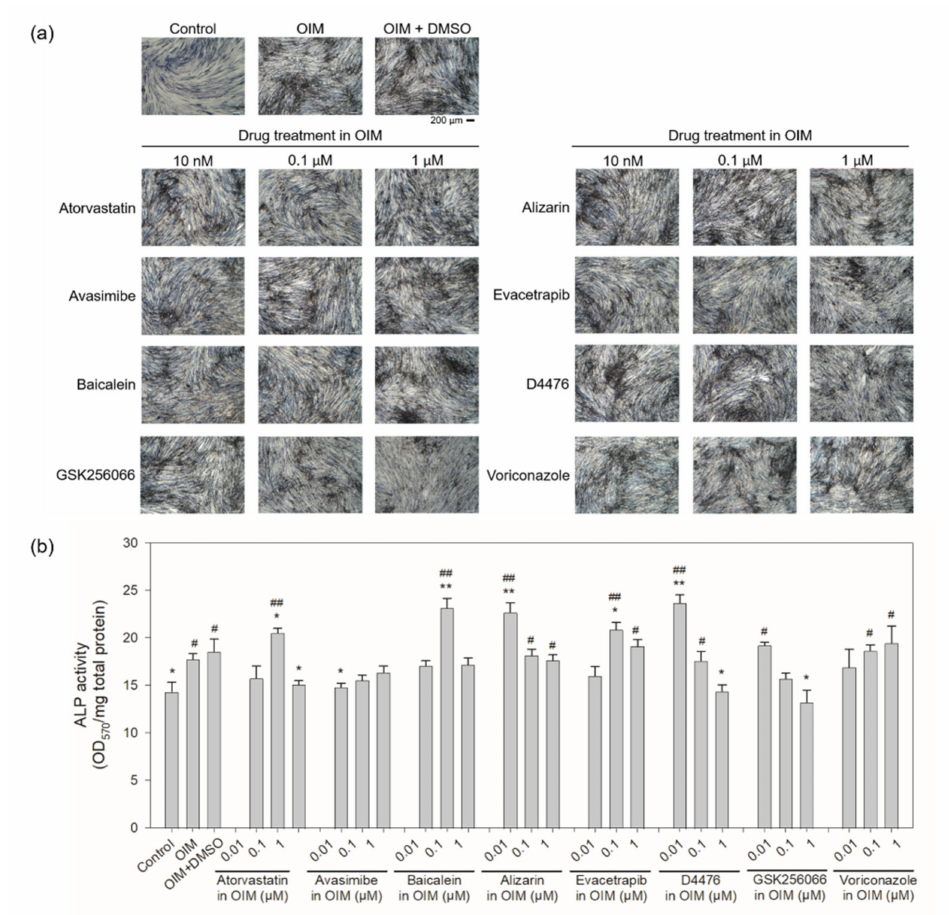
Figure 7. Effect of potential sclerostin-binding inhibitors on the ALP activity of hBMSCs. ( a ) Human BMSCs were cultured in OIM in the presence of various concentrations of potential sclerostin inhibitors, as well as the negative controls GSK256066 and voriconazole, for 21 days, followed by cell staining with Pierce 1-Step NBT/BCIP Solution (Thermo Fisher Scientific, Waltham, MA, USA) according to the manufacturer’s instructions. ( b ) The level of alkaline phosphatase activity was quantitated by solubilizing the cells in DMSO and determining the optical density at 570 nm, which was then normalized to total protein (mg). Error bars represent standard deviations ( n ≥ 3). # p < 0.05 and ## p < 0.01, compared to the control; * p < 0.05 and ** p < 0.01, compared to the OIM controls.